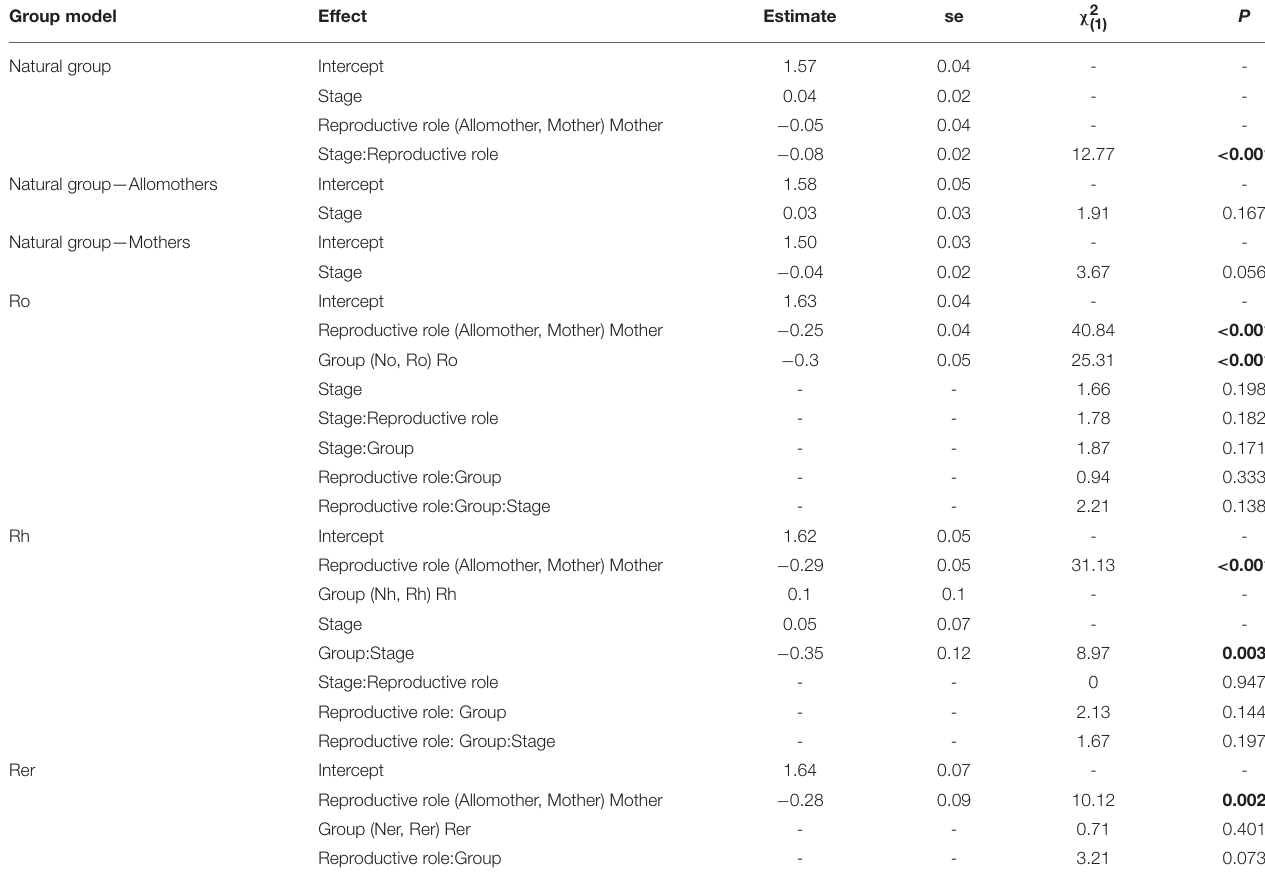
TABLE 2 | Statistical analyses of SMR in mothers and allomothers of the natural and removal groups in the social S. dumicola . Group